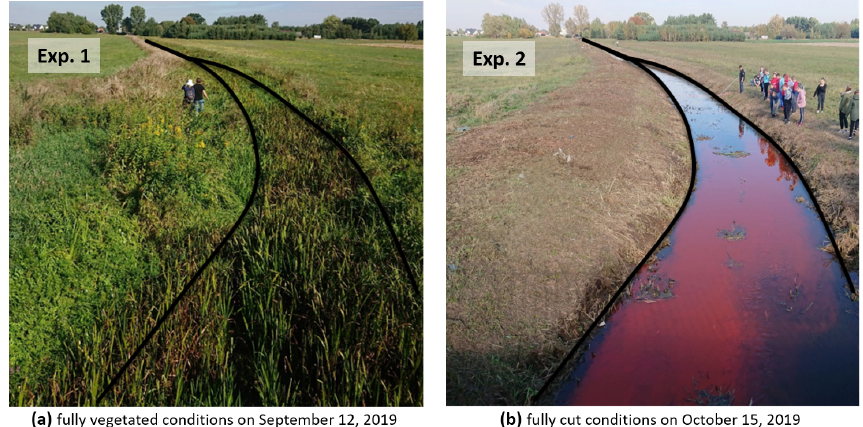
Figure 3. Warszawicki Channel – view towards the downstream sub-reaches (a) before and (b) after the vegetation